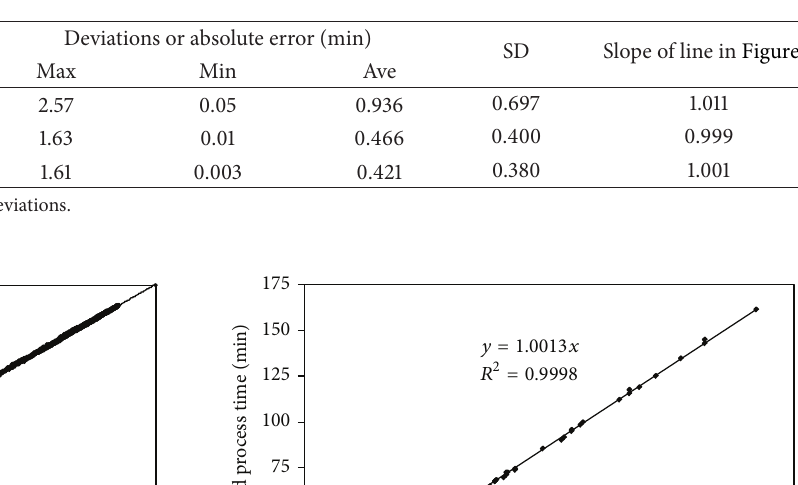
Table 1: Comparison of process time calculated using 𝑔 values from the Stumbo [7] tables, ANN model of Sablani and Shayya [21], ANN model of Mittal and Zhang [22], and mathematical model of this work.